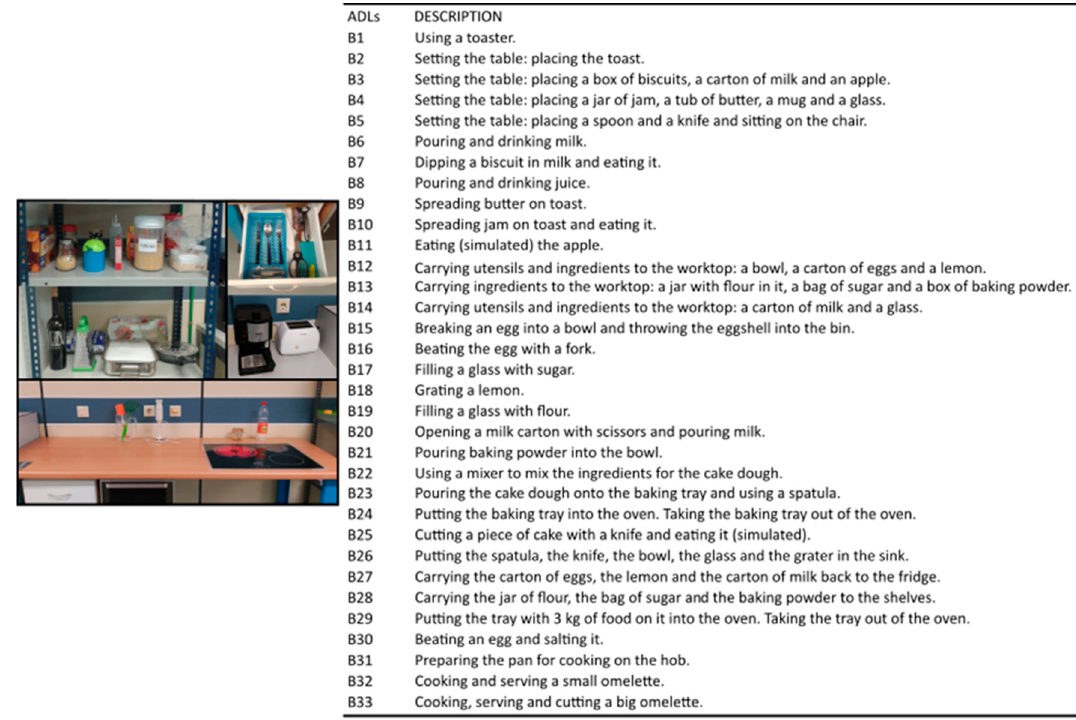
Figure 2. Experiment B: List of ADLs performed and scenarios with the objects used to evaluate the goodness of the method.